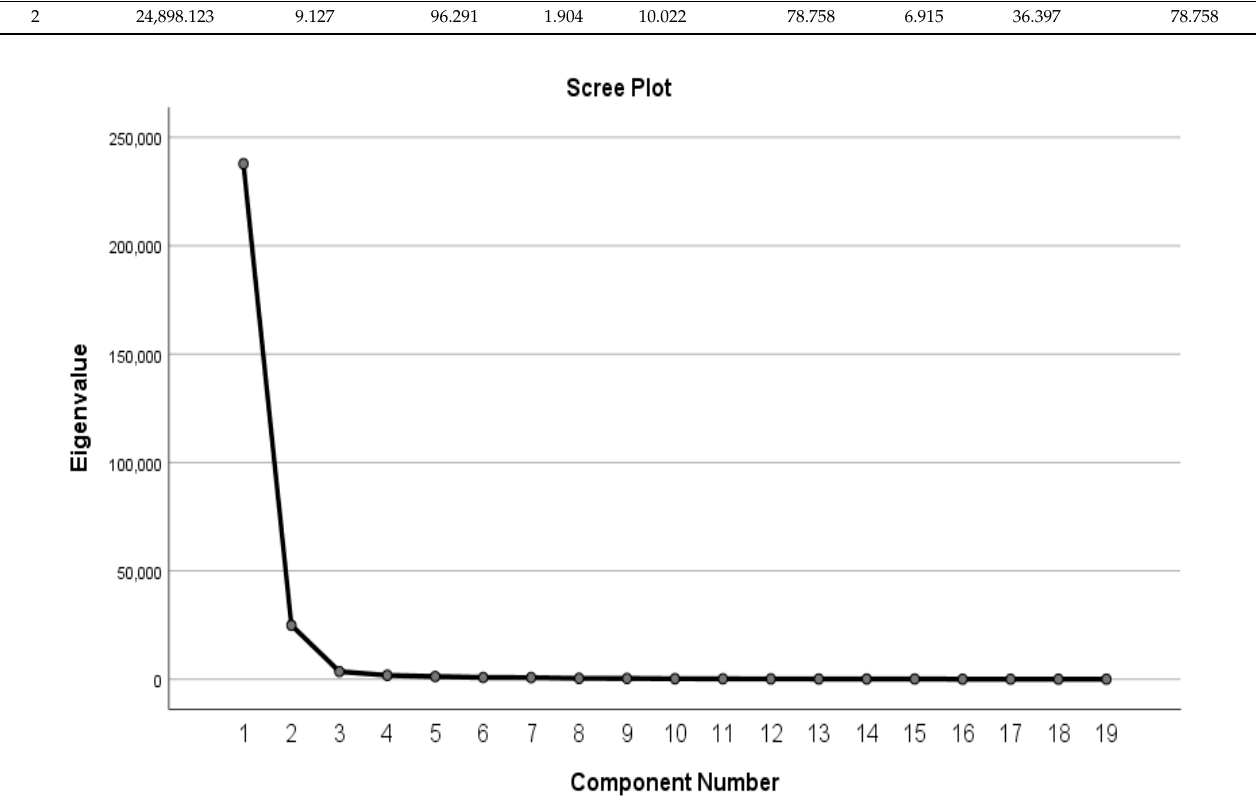
Figure 1. Factor Analysis Scree Plot.